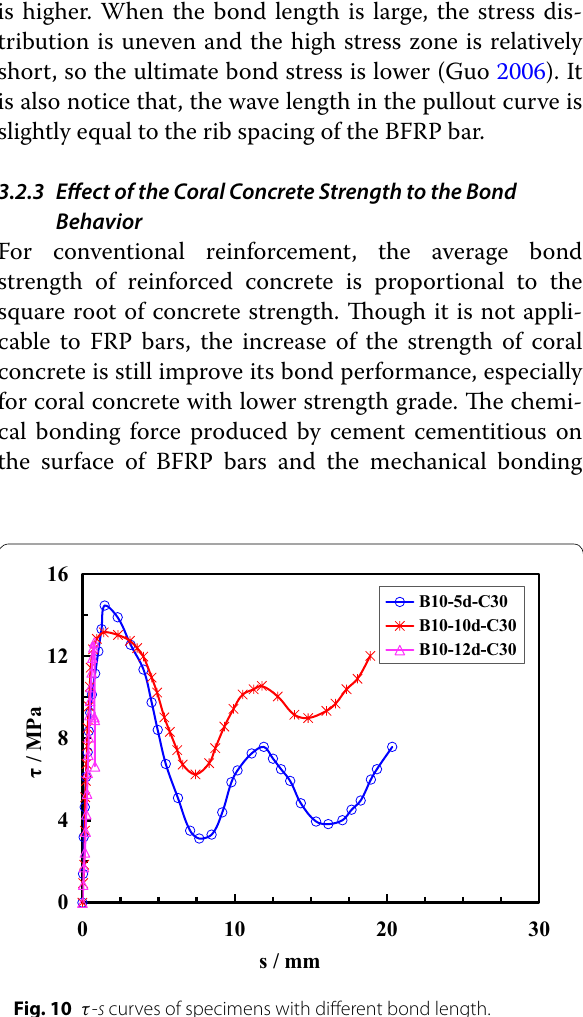
Fig. 10 τ - s curves of specimens with different bond length.